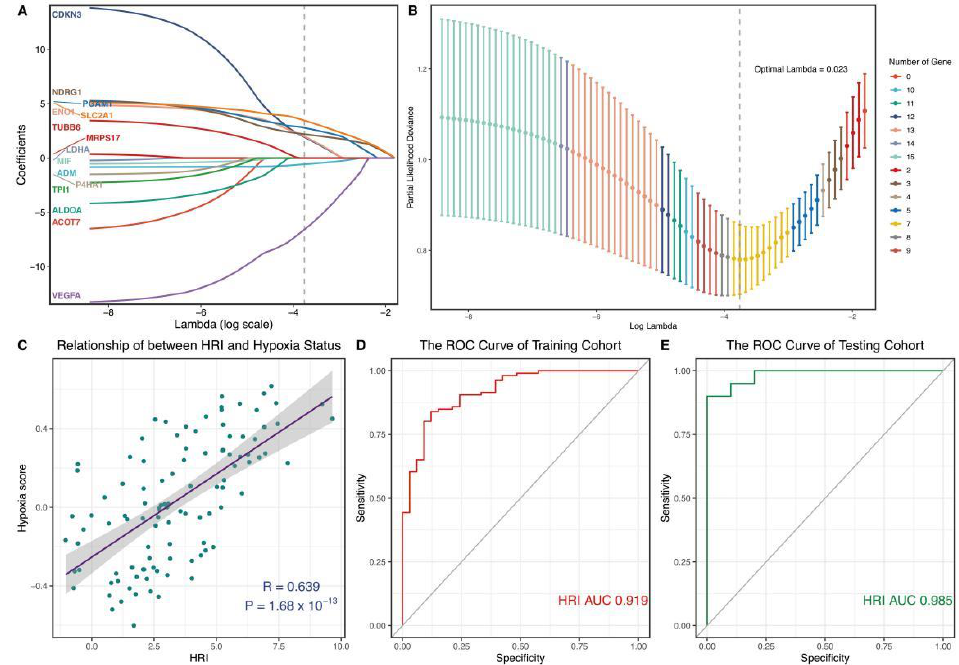
Figure 5. Construction and verification of hypoxia − related diagnostic marker. ( A , B ) Hub hypoxia- related genes were identified by LASSO regression analysis. Optimal Lambda = 0.023. ( C ) Pearson correlation analysis between HRI and hypoxia status. ( D , E ) Time-dependent ROC curve analysis of HRI. ( D ) Training cohort. ( E ) Testing cohort. LASSO: least absolute shrinkage and selection operator; ROC: receiver operating characteristic; HRI: hypoxia-related index.